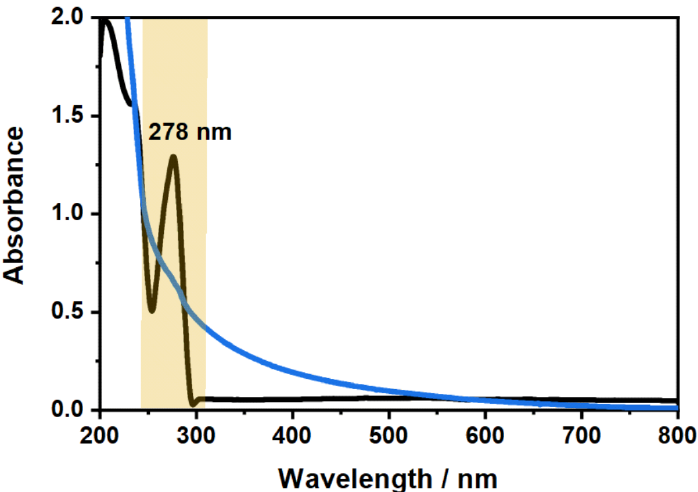
Figure 2. Comparison of the absorbance spectra of CBD (black) measured at a mass concentration of 0.1wt% in EtOH and the copolymer microgel (blue) measured at a mass concentration of 0.3wt% in water. The position of the exclusive absorbance band of CBD, which can be used to investigate the loading and release inside the microgel network, is indicated.